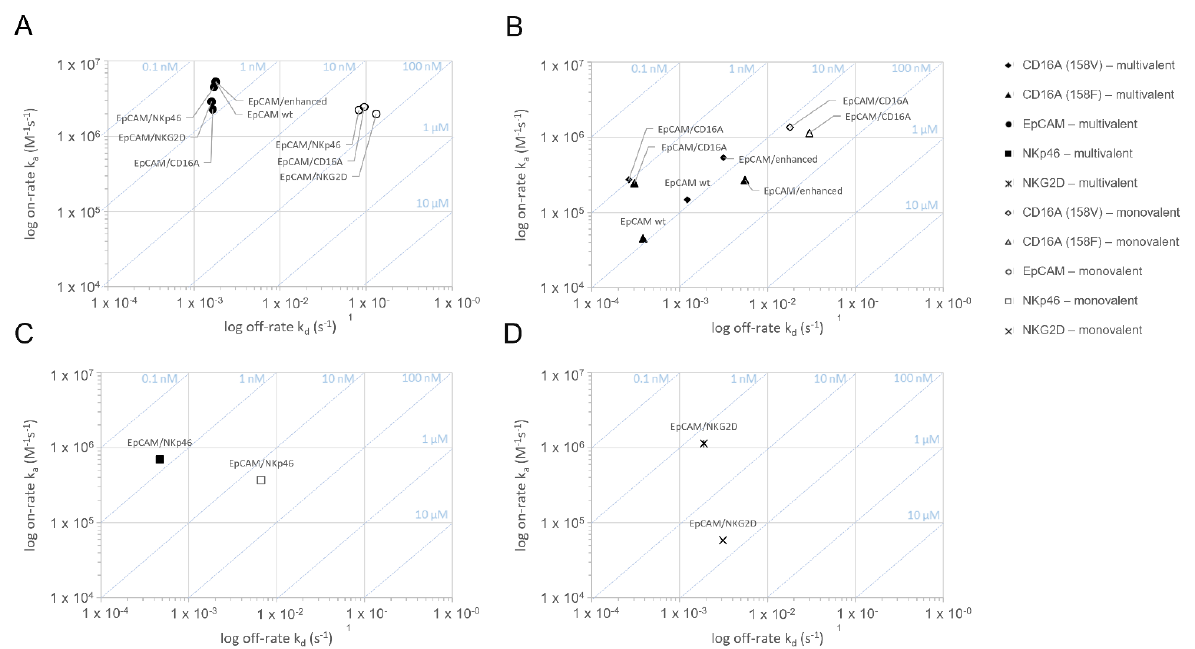
Figure 1. Assessment of the monovalent and multivalent binding kinetics of bispecific ICE ® constructs to recombinant human EpCAM, CD16A, NKG2D, and NKp46 antigens: on-/off-rate map.The binding interaction of EpCAM/CD16A, EpCAM/NKp46, EpCAM/NKG2D, anti-EpCAM IgG1, and anti-EpCAM Fc-enhanced IgG1 was measured on human EpCAM ( A ), human CD16A 158V/F ( B ), human NKp46 ( C ), and human NKG2D ( D ) in SPR at 37 °C using an experimental set-up allowing for the monovalent or multivalent interaction ( n = 3). Binding curves were fitted to a 1:1 binding model to evaluate the kinetic rate constants k a and k d as well as a dissociation equilibrium constant K D . The arithmetic means were calculated and plotted. SPR stands for surface plasmon resonance.